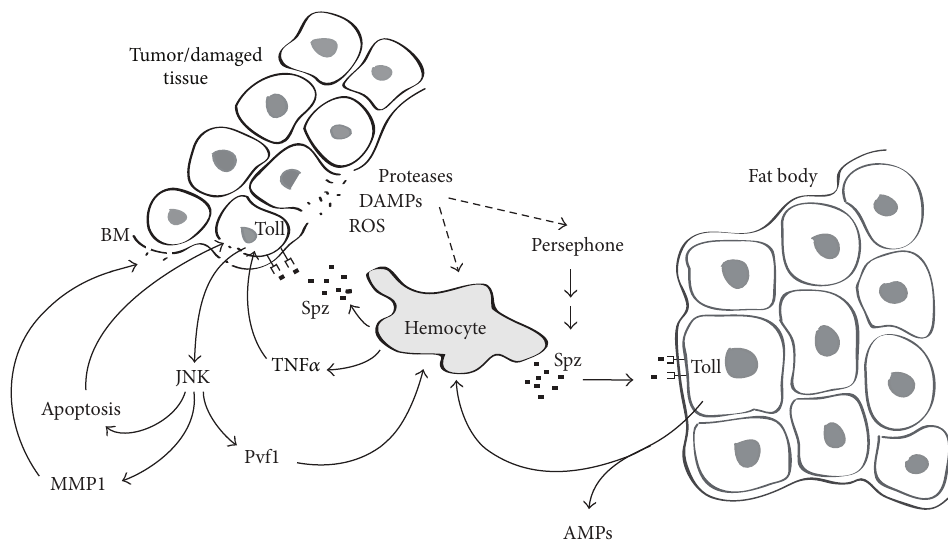
Figure 1: Tumors appear as damaged tissue, releasing DAMPS including ROS and triggers that recruit hemocytes and activate the proteolytic cascade that results in the production of active Spaetzle (Spz). Spz acts both locally and in the fat body to stimulate signalling through Toll/NF 𝜅 B. Hemocytes also release the short-range signal TNF 𝛼 which, along with Toll signalling, activates JNK in the target tissue. JNK signalling produces cytokines like Pvf1, degrades basement membrane via matrix metalloproteases (MMP1), and promotes apoptosis. All these effects tend to recruit and activate further hemocytes at the damage site to generate an effective inflammatory